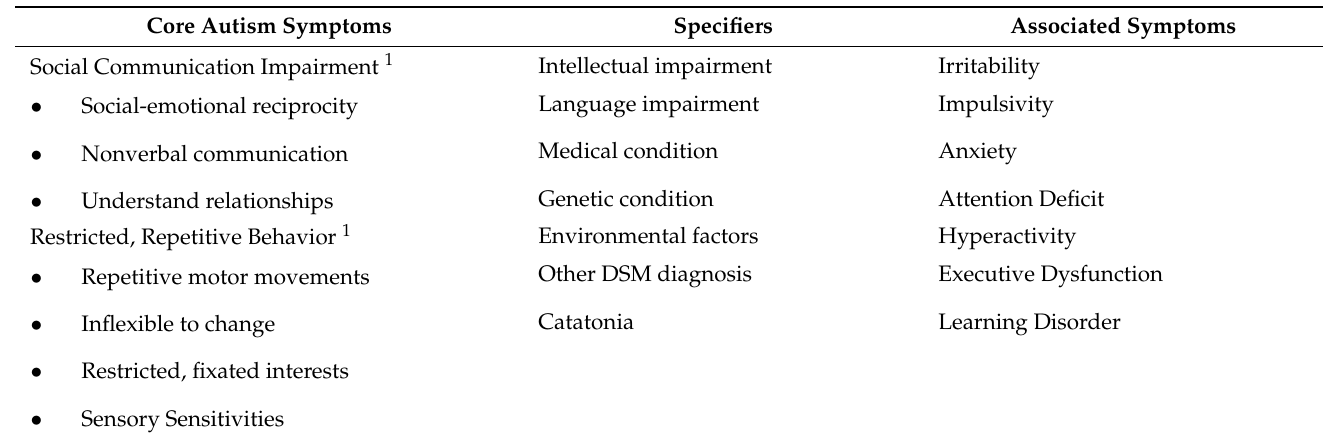
Table 1. Diagnostic criteria for Autism Spectrum Disorder as well as Specifiers and common associ- ated behavioral and cognitive